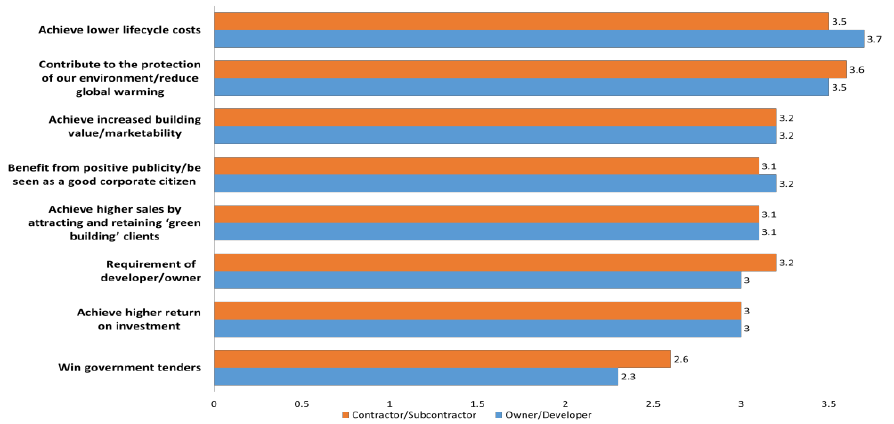
Figure 2. Motivesto involvement in green buildings’ market according to (BCI) survey. (Asia,2014)